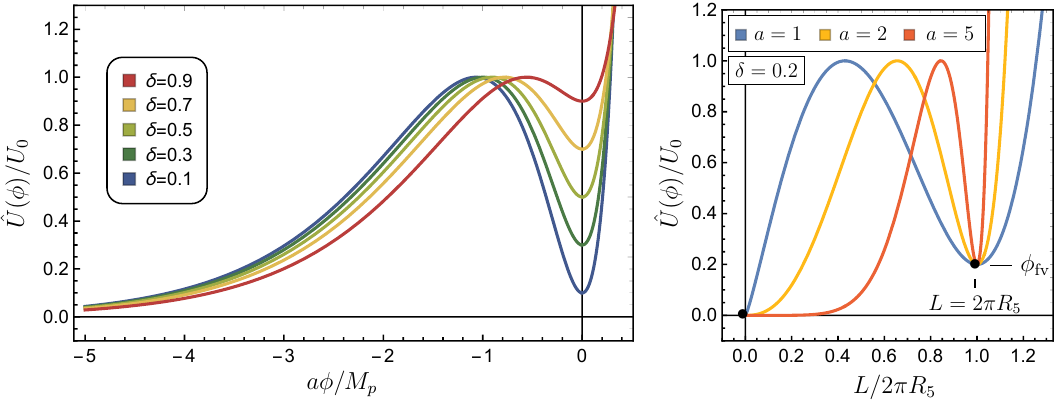
 ) Figure 20: Potential U ( ˆ U ( φ ) , as given in eq. (4.1), for several values of δ ≡ U fv /U 0 , as  (cid:16)q (cid:17) exp . Larger values of a create 2 φ/M p 5 3